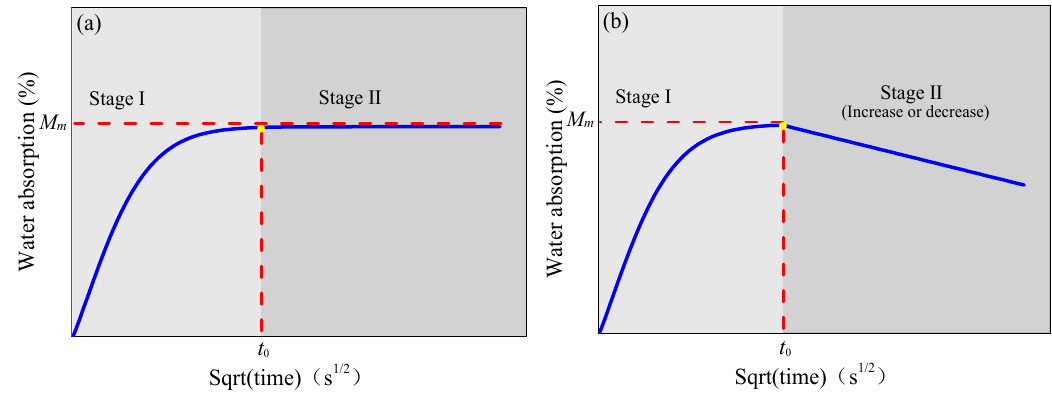
Figure 12. Schematic diagram of the ageing of the specimens with different thicknesses through cross section at a same certain ageing time.